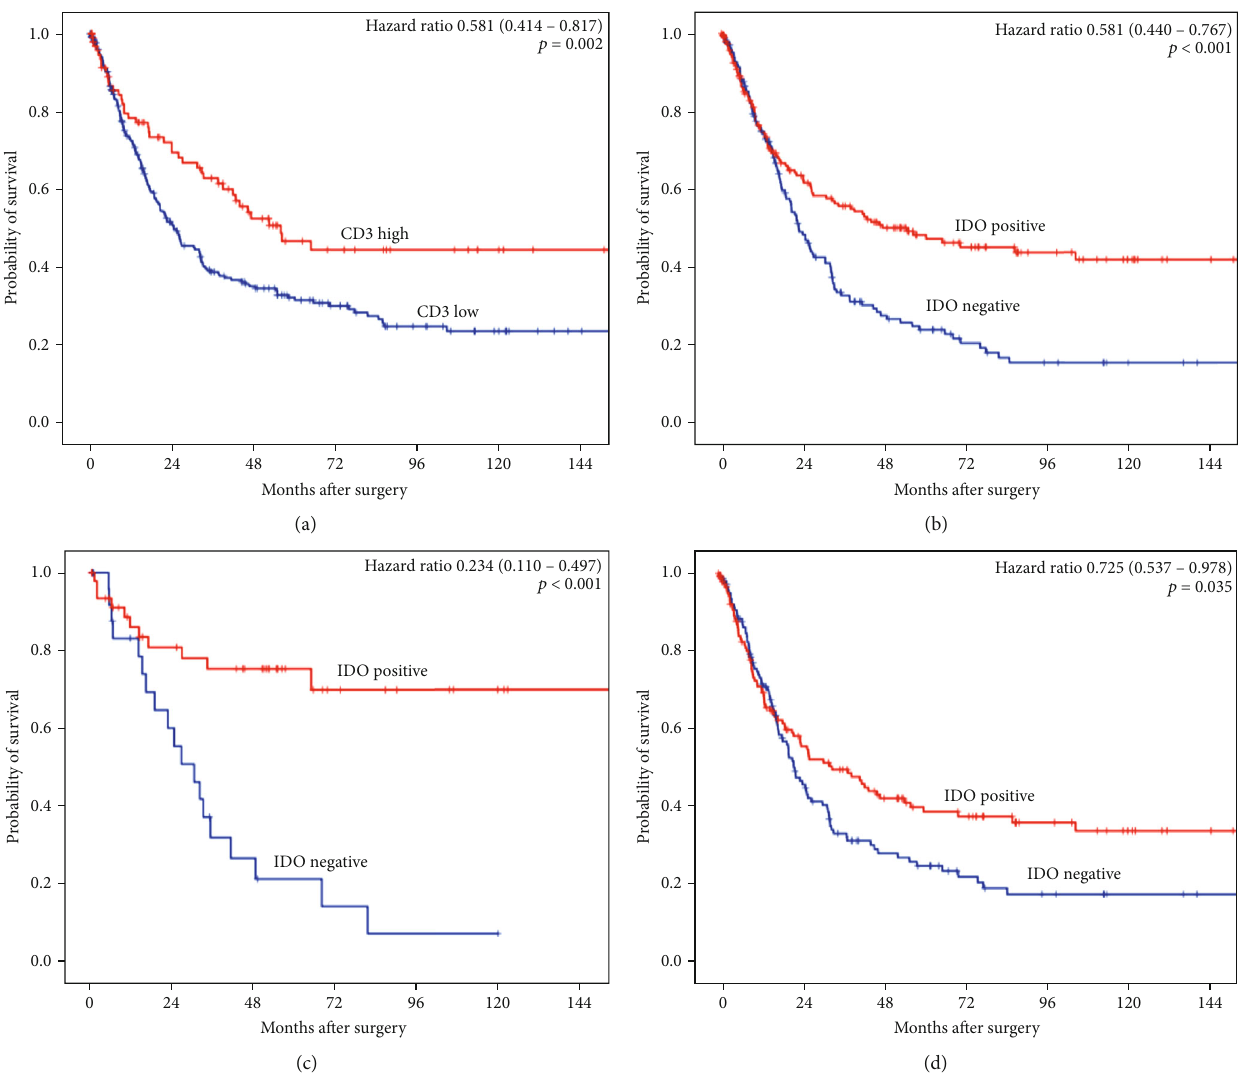
Figure 4: (a) High amounts of CD3-positive T cells are associated with an improved OS in esophageal adenocarcinoma. (b) Tumors with IDO-positive TILs show better median overall survival of 47.7 months in IDO-positive tumors compared to a median OS of 22.7 months for IDO-negative tumors. (c) In the pT1/2 group, patients with IDO-positive expression have a calculated average OS of 142.1 months (median not reached) compared to an average OS of 37.1 months (median OS 30.5 months), p < 0 : 001 . (d) The survival di ff erence remains signi fi cant also in the subgroup of pT3/4 tumor stages with median OS of 33.3 months for IDO-positive tumors and 22.1 months for IDO-negative tumors ( p = 0 : 035 ).